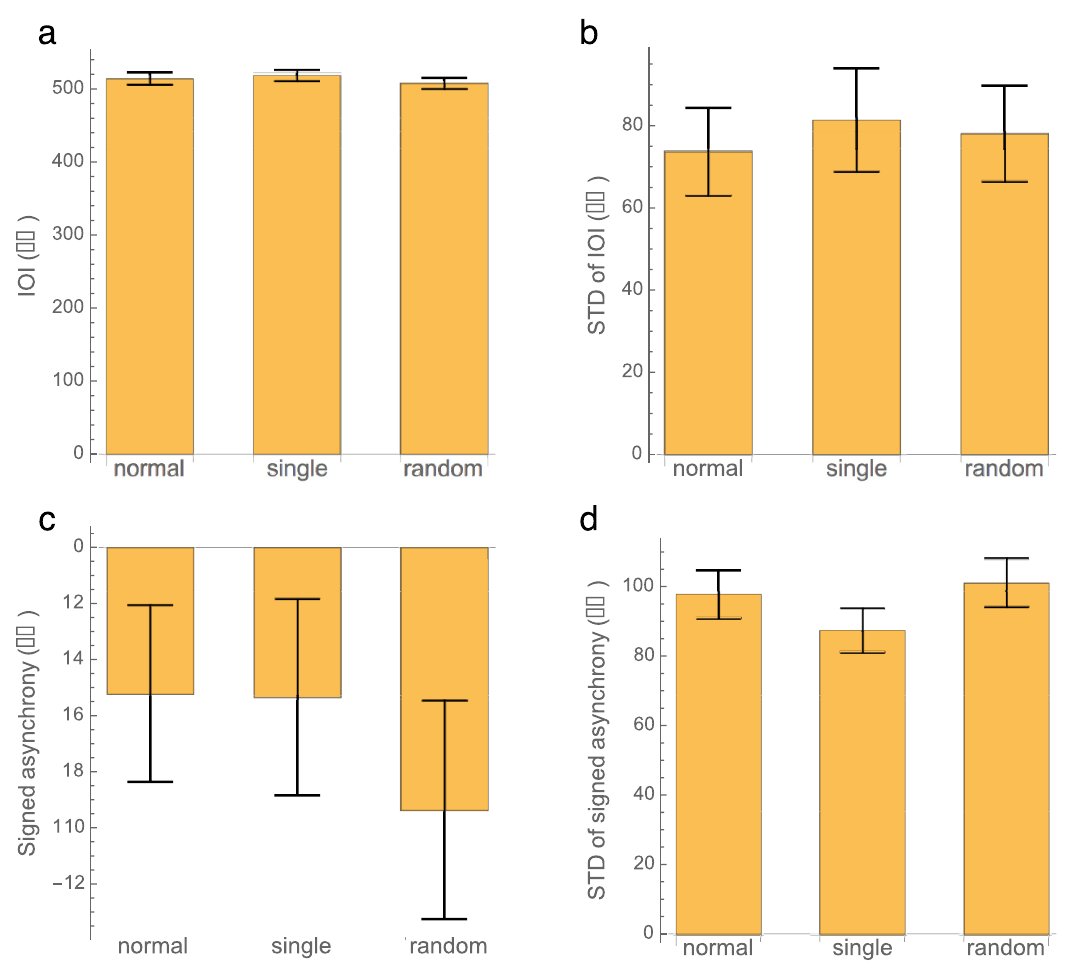
Fig 3. a/b: Inter onset interval (IOI) and the standard deviation (STD) of the inter onset interval. No significant difference was found between conditions. 3c: The signed asynchrony to the nearest metronome beat. There was no difference between